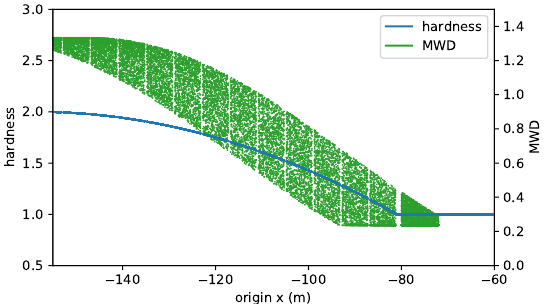
Figure 10. The assumed hardness profile (blue) at the left source and the corresponding MWD signal (green) after introducing a 12.5 m measurement location error at the source.